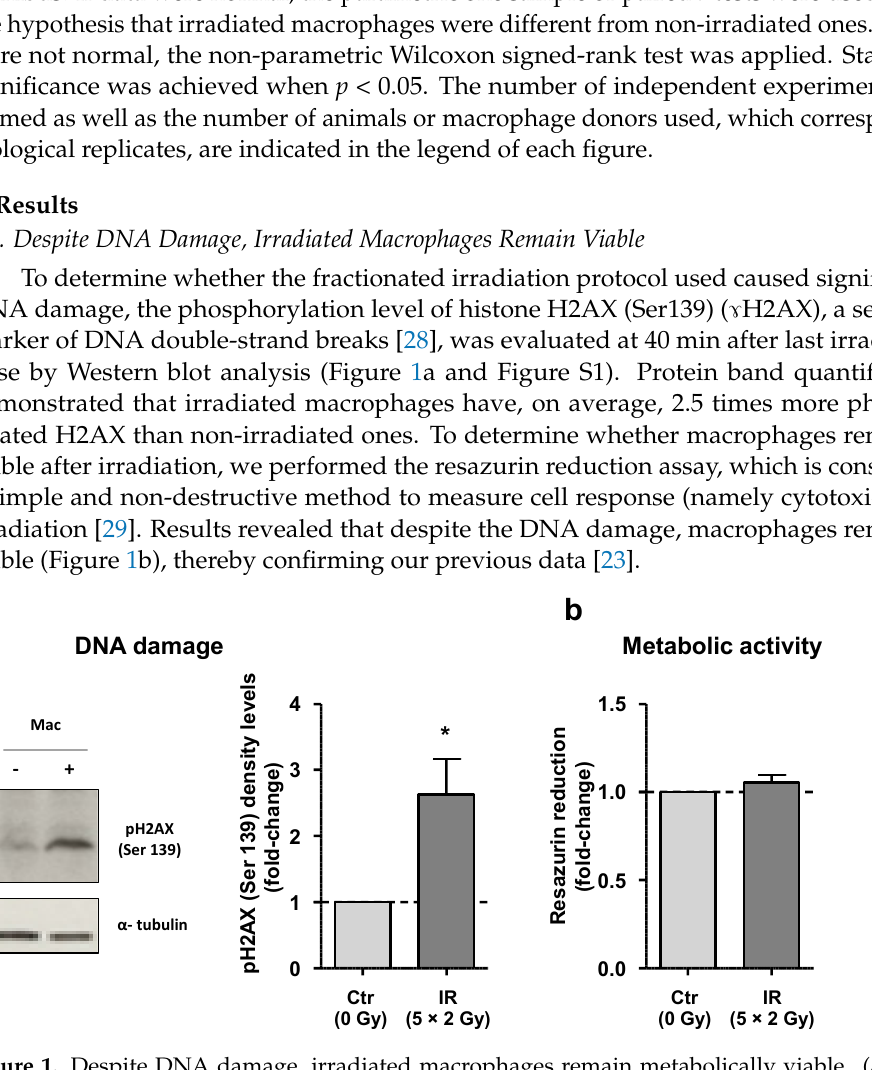
Figure 1. Despite DNA damage, irradiated macrophages remain metabolically viable. ( a ) DNA damage induced by cumulative ionizing radiation doses (5 × 2 Gy) in macrophages was confirmed by Western blot analysis for phosphorylated H2AX (Ser139) ( 7 H2AX), 40 min after exposure to the last irradiation dose. Quantification of 7 H2AX band intensity of irradiated macrophages, normalized to the control, is represented in the graph ( n = 3). ( b ) The metabolic activity of irradiated macrophages ( n = 8) was measured using the resazurin reduction assay and normalized to that of non-irradiated ones. Mean ± SEM is presented. The whole blots (uncropped blots) showing all bands with all molecular weight markers on the Western are provided in the Supplementary Materials. * p <